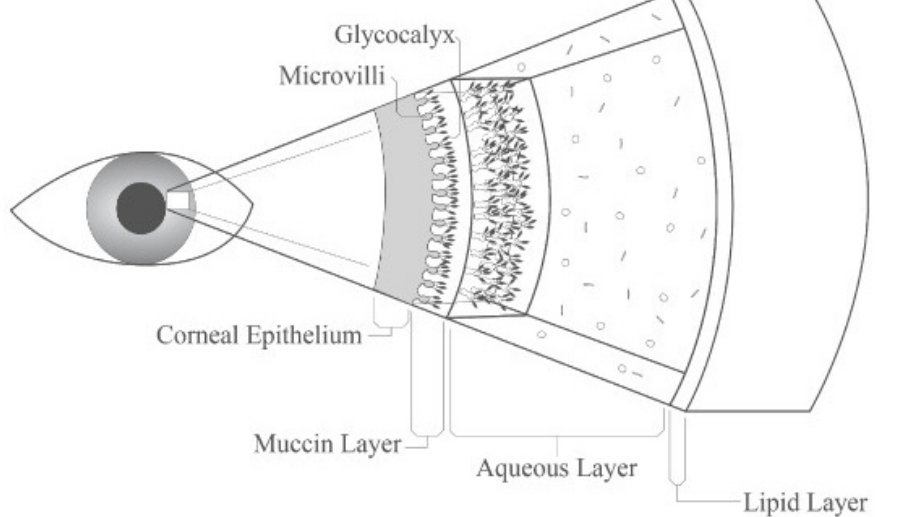
Figure 1 Schematic illustration of the precorneal tear film showing the corneal epithelium with its glycocalyx, mucin, aqueous and lipid